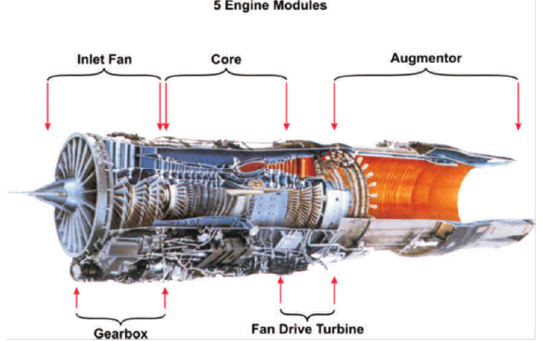
Fig. 1. F100 engine design structure